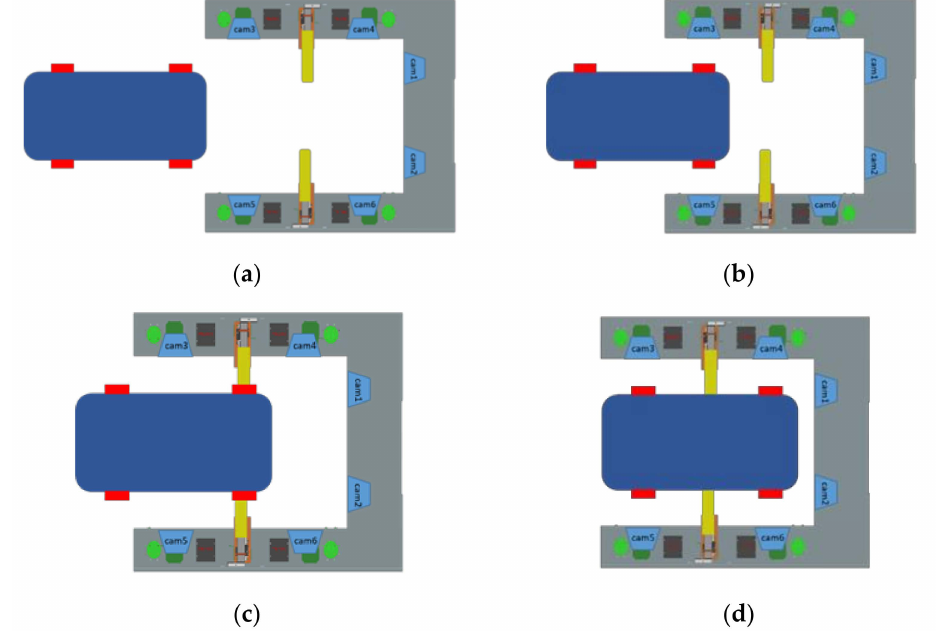
Figure 5. How to move for precise position correction of the mobile station. ( a ) A situation in which the mobile station starts docking the AEV, ( b ) the mobile station recognizes the rear leg of the AEV, ( c ) the mobile station enters and camera images enter between the legs of the AEV, and ( d ) the camera on the mobile station recognizes all of the legs of the